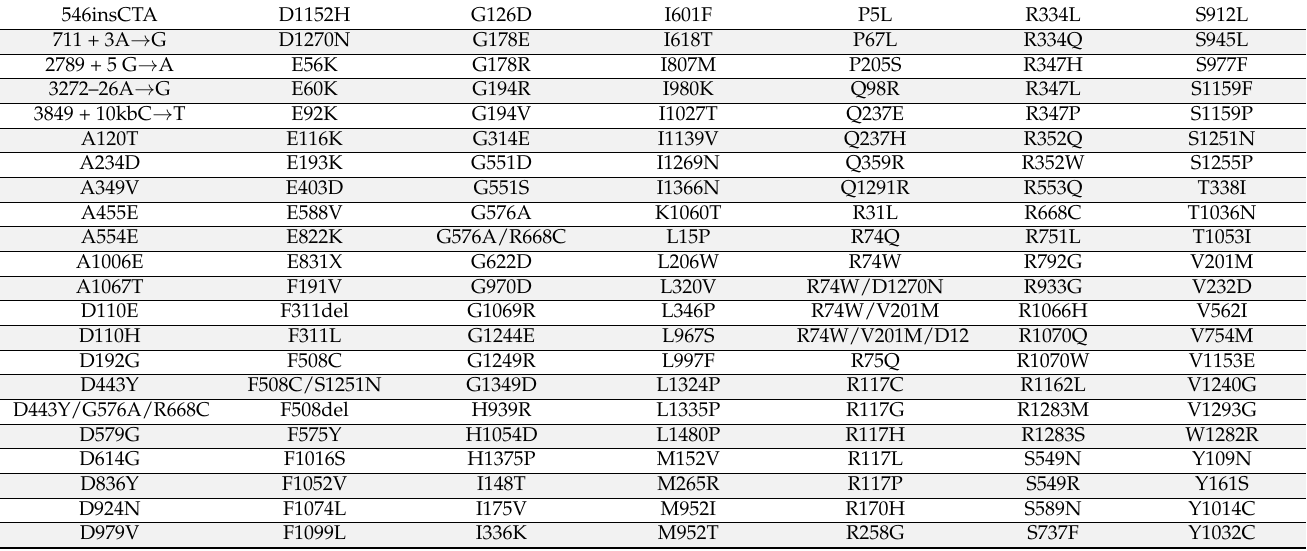
Table 3. List of CFTR mutations eligible for the treatment with Tezacaftor/Ivacaftor and approved by the FDA. Patients should carry F508del mutation in both alleles or at least one copy of the mutations listed here. Available from https://www.vertexgps.com, accessed on 14 November